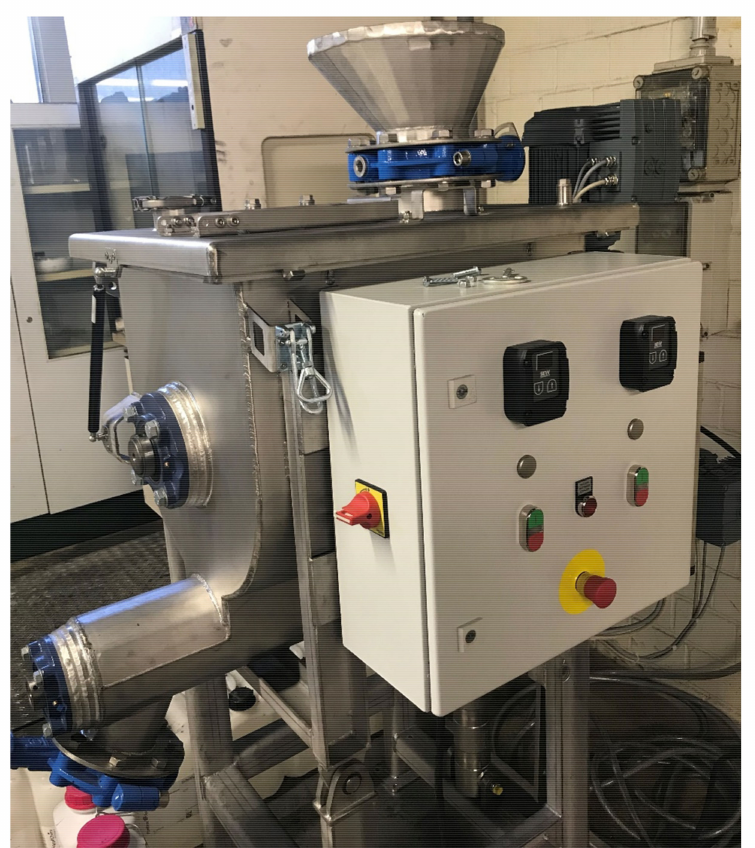
Figure 7. New developed dry digestion reactor (main components: reaction vessel, system with nozzles for injection of water and acid; cover; special mixing system, engine, discharging system, and electronics).